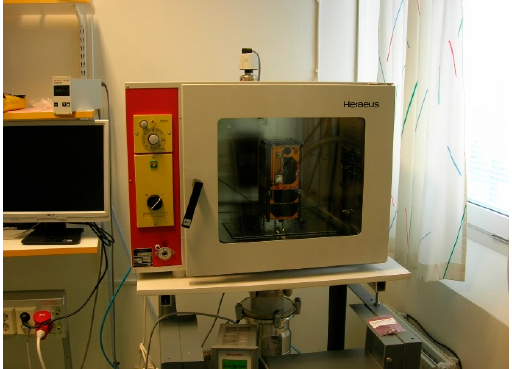
Figure 14. SE01 in the bake-out chamber.